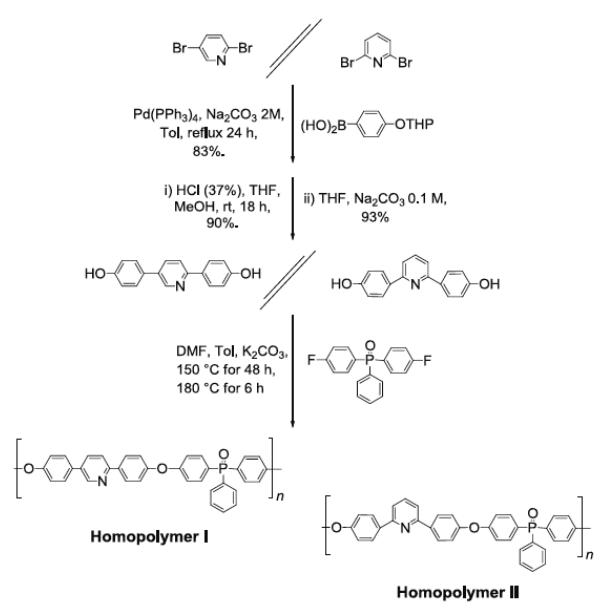
Figure 7. Rigid aromatic polymer based on pyridine. Reaction schemes proposed in Ref. [68].